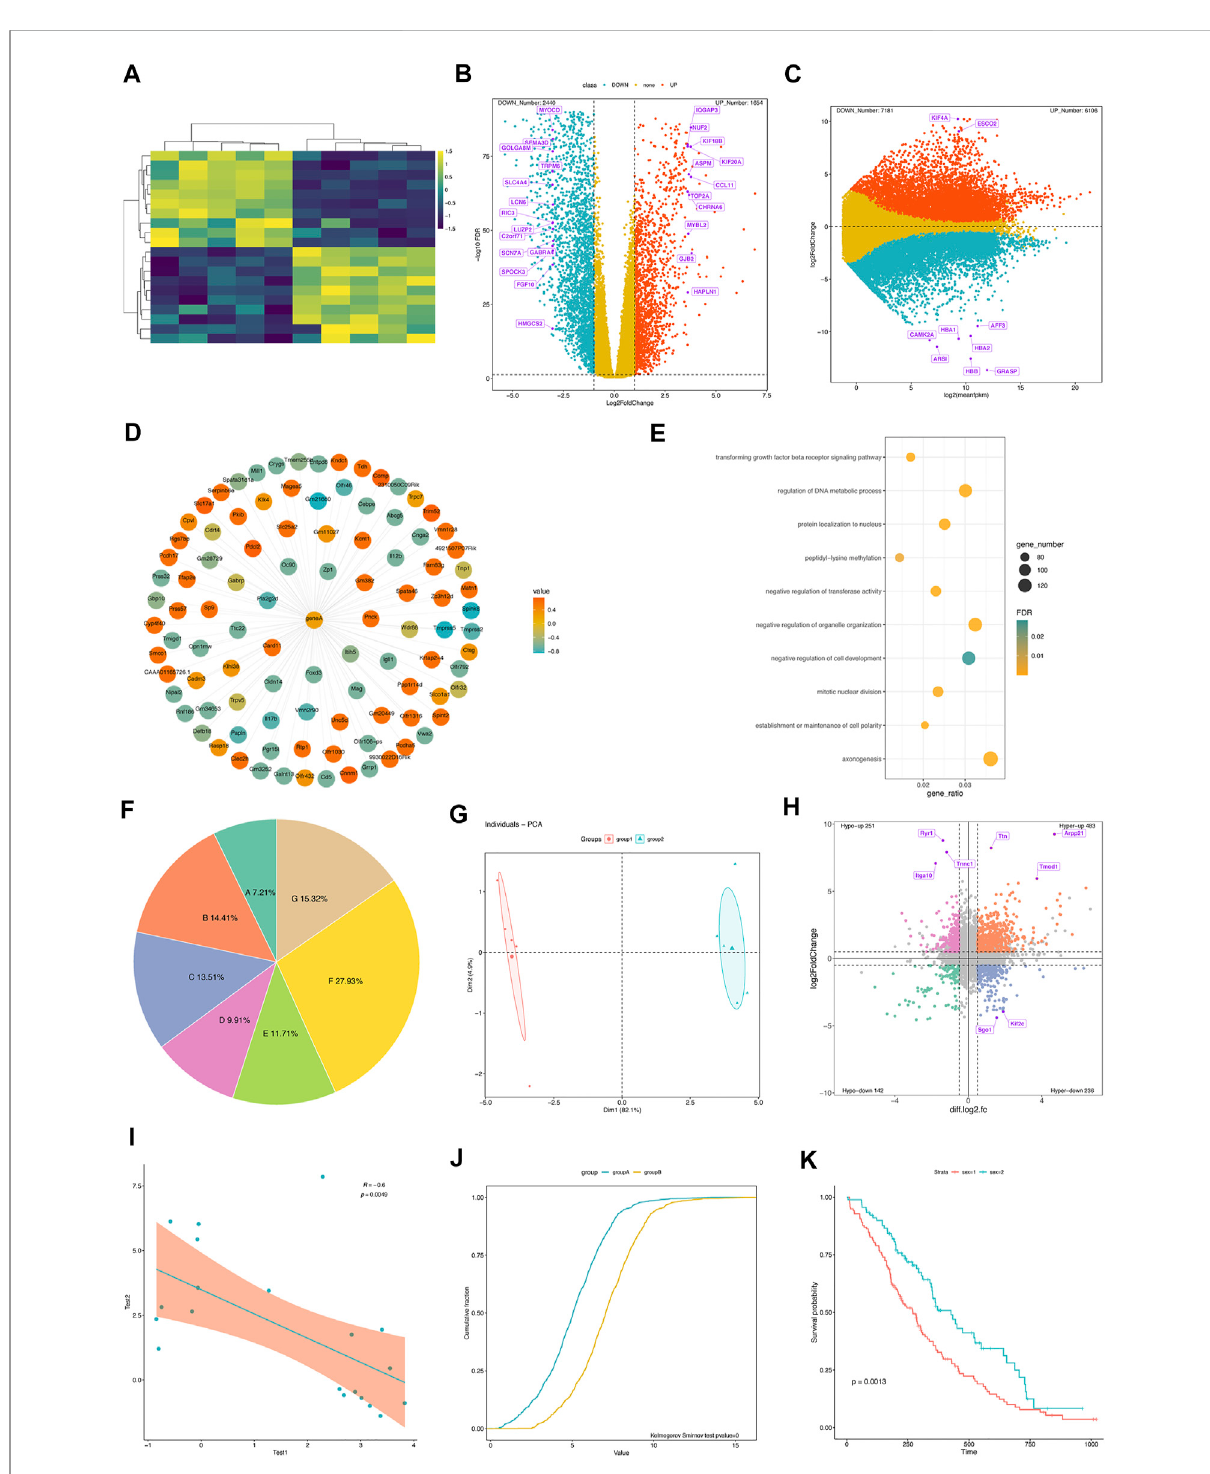
FIGURE 1 Flow diagram of the retrospective protocol for case inclusion and exclusion and data collection. Some representative visualization results from GraphBio. (A) Gene expression heatmap. Rows represent genes, and columns represent samples. Yellow represents upregulation, and blue represents downregulation. (B) The volcano plot shows signi fi cantly differentially expressed genes. The x -axis represents log 2 -transformed fold changes, and the y -axis represents − log 10 (FDR). False discovery rate, FDR. Red represents upregulation, blue represents downregulation, and yellowrepresentsgenesthatarenotstatisticallysigni fi cant.Somegenesofinterestaremarkedinpurple. (C) MAplotshowssigni fi cantlydifferentially expressed genes. The x -axis represents mean expression values of genes, and the y -axis represents log 2 -transformed fold changes. Red represents